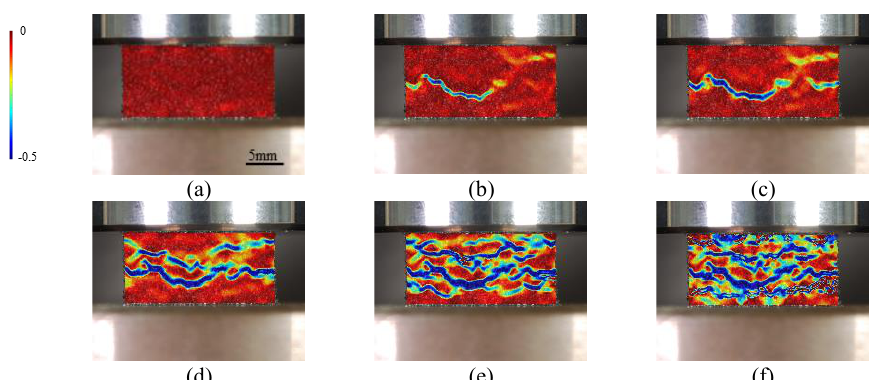
Fig. 6. Strain distribution in quasi-static test in the case of expansion ratio of 12; at engineering strain of (a) 0.04, (b) 0.07, (c) 0.10, (d) 0.20, (e) 0.30, (f)